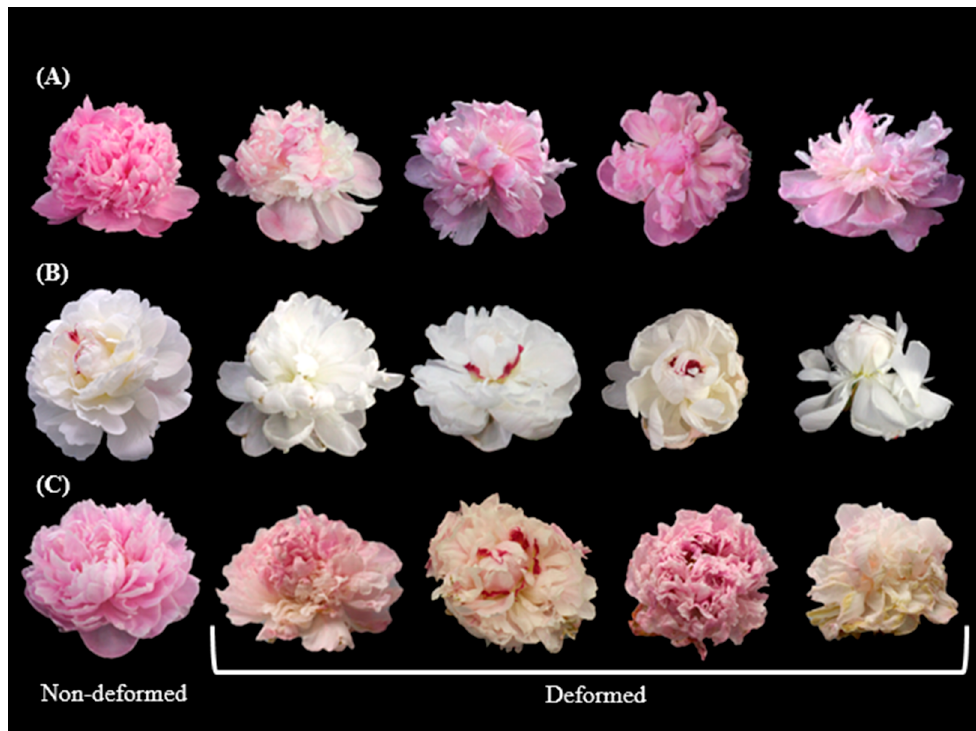
Figure 3. Floral deformities in Paeonia lactiflora Pall. hybrids ( A ) ‘Monsieur Jules Elie’, ( B ) ‘Festiva Maxima’, and ( C ) ‘Sarah Bernhardt’. Deformity severity increased as storage duration increased and was observed as a loss of petals primarily in the center of the flower, curled petals, not fully expanded petals, or center petals not opening similar to the outer petals.